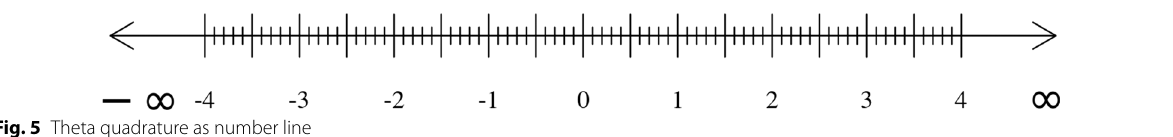
Fig. 5 Theta quadrature as number